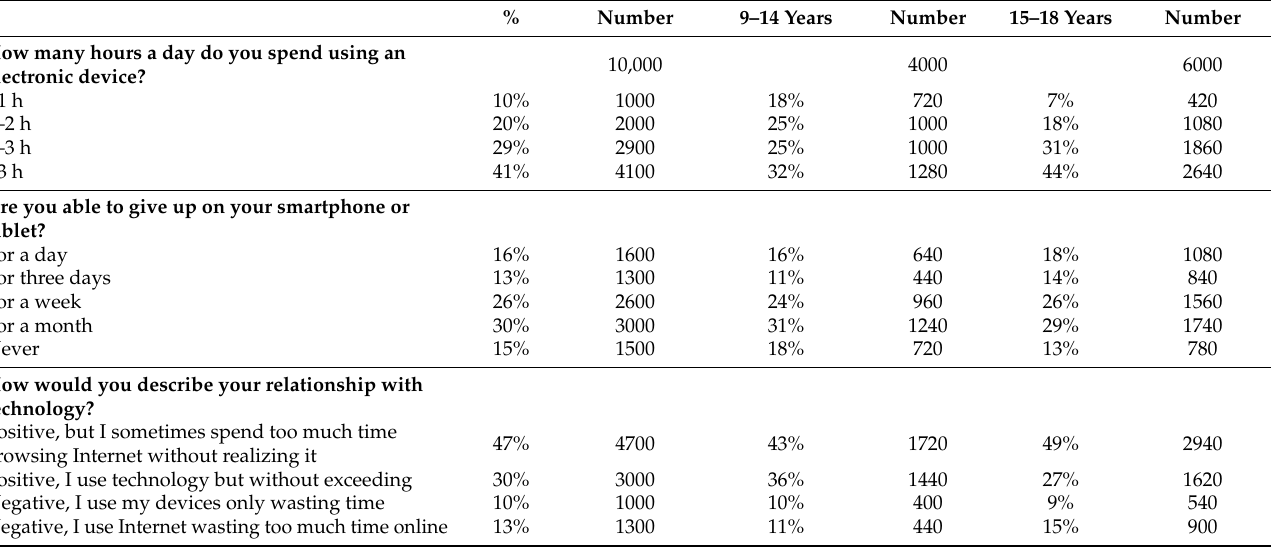
Table 2. Questionnaire about MD usage and perception among children and adolescents.